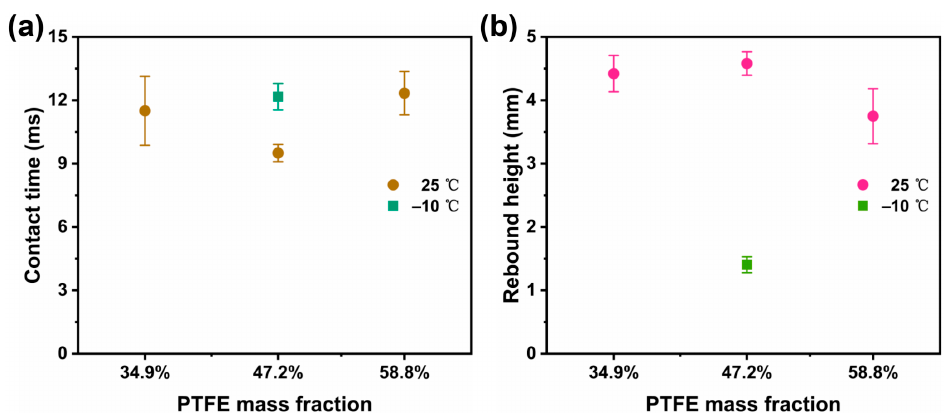
Figure 4. Contact time ( a ) and rebound height ( b ) of water droplets placed on coatings with 34.9%, 47.2% and 58.8% mass